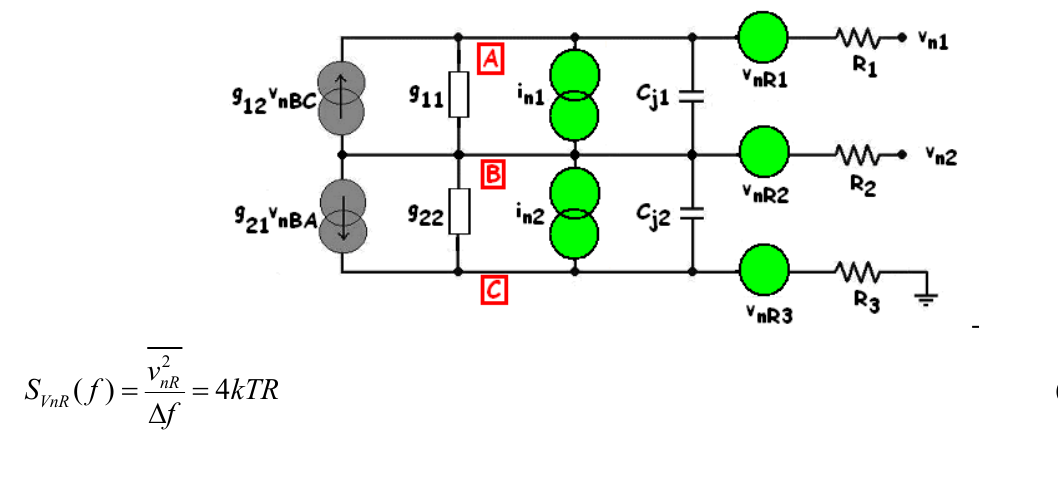
Figure 14. Equivalent noise circuit of the BDJ